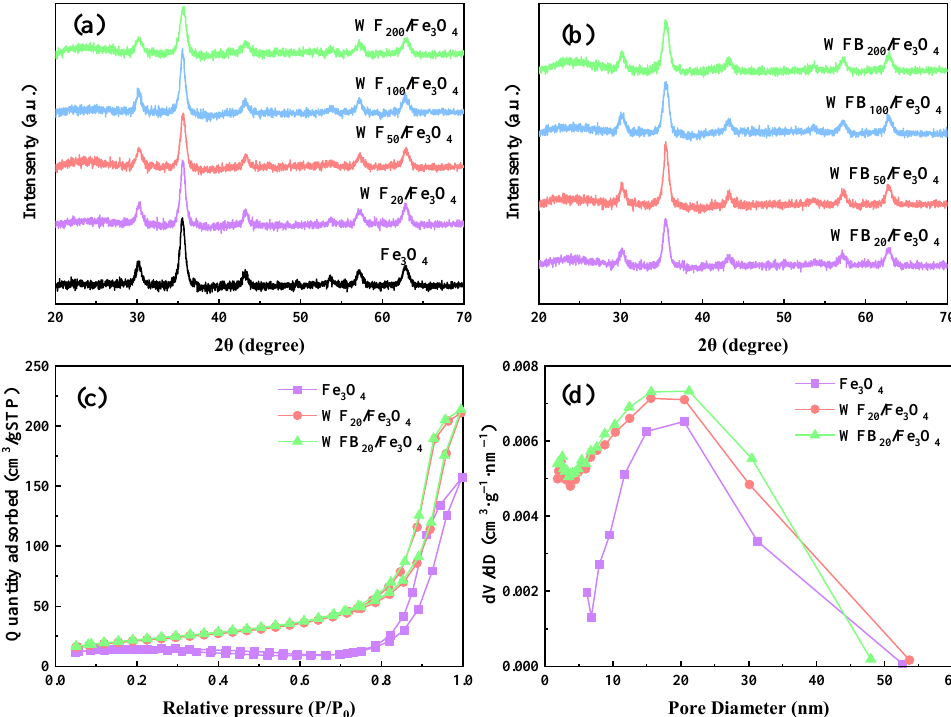
Figure 2. XRD patterns of ( a ) Fe 3 O 4 , WF/Fe 3 O 4 , and ( b ) WFB/Fe 3 O 4 ; ( c ) the N 2 adsorption-desorption isotherms and ( d ) pore size distributions of Fe 3 O 4 , WF 20/ Fe 3 O 4 , and WFB 20 /Fe 3 O 4 .